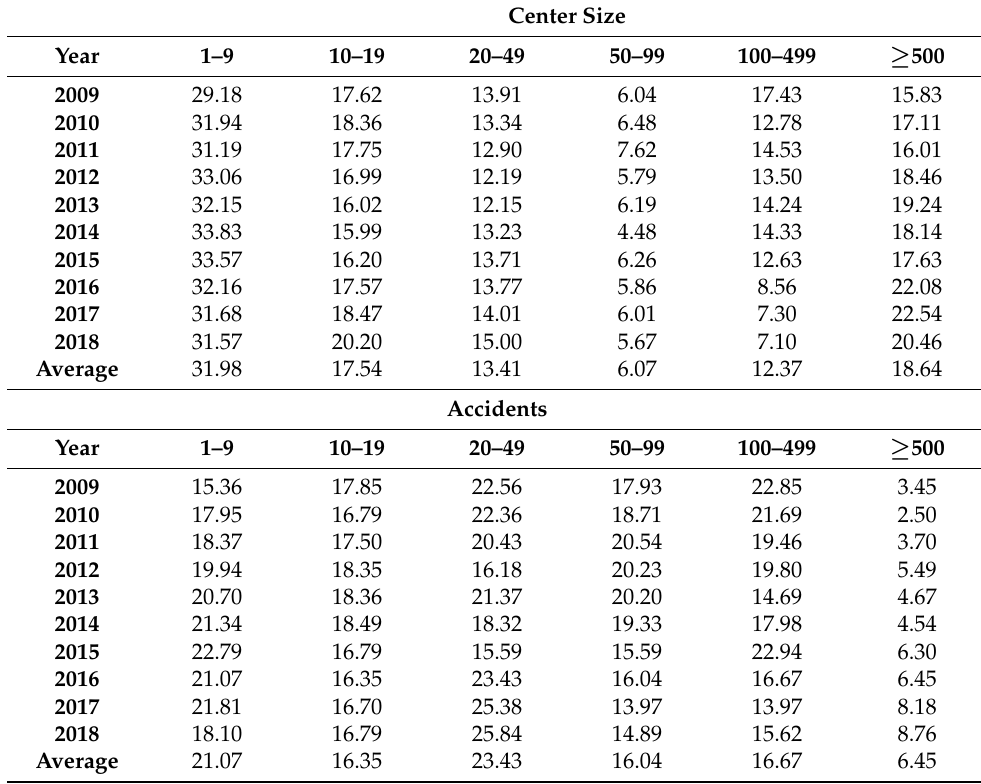
Table 6. Workers and accidents per size in PP (%).